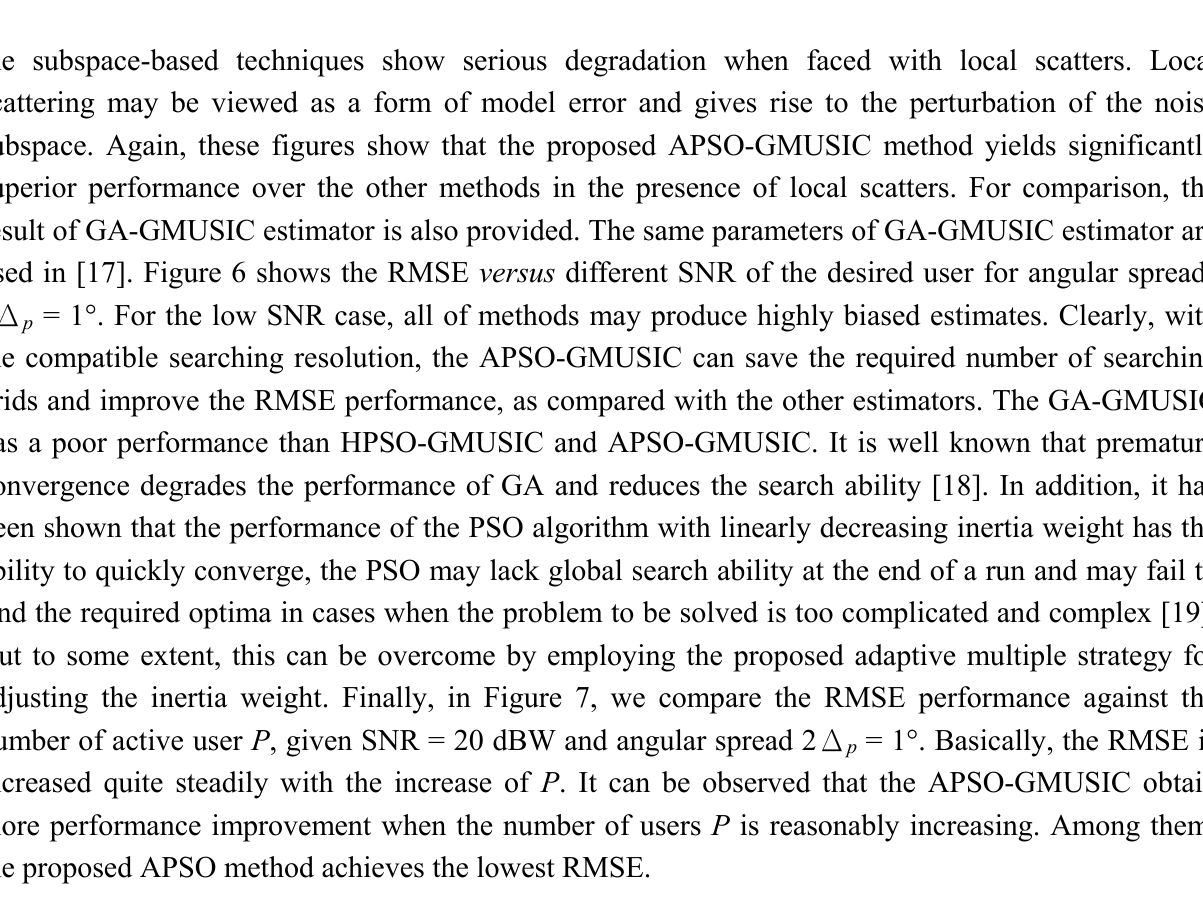
Figure 3. DOA RMSE versus the number of